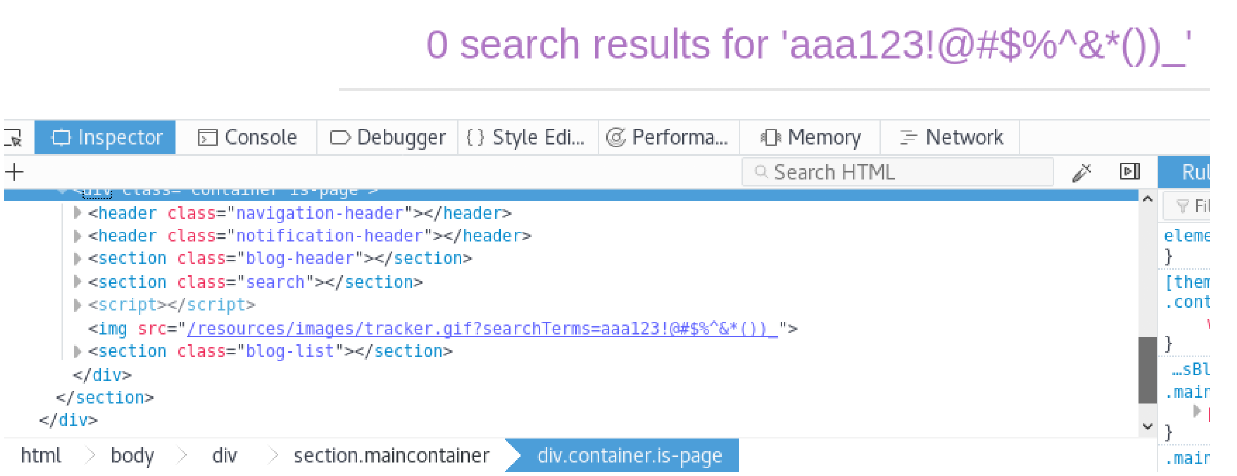
Figure 5. DOM-XSS